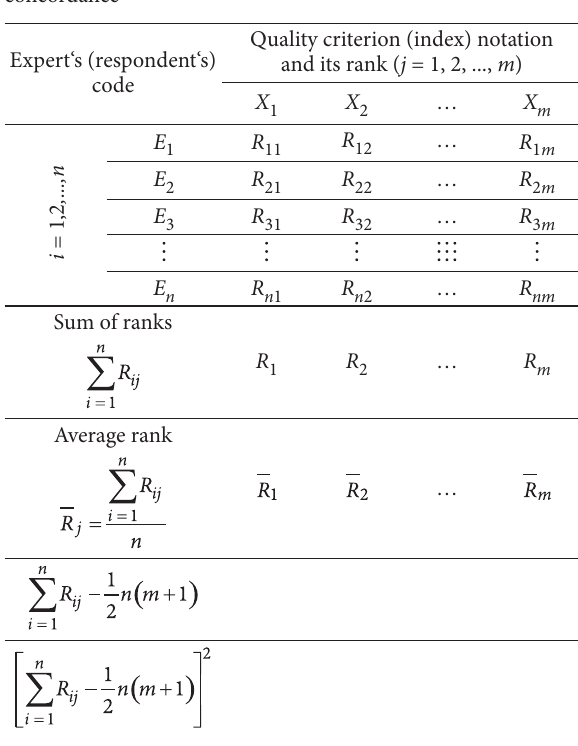
Table 2. Experts’ opinion ranks and their use in determining an average rank and value W of Kendall’s coefficient